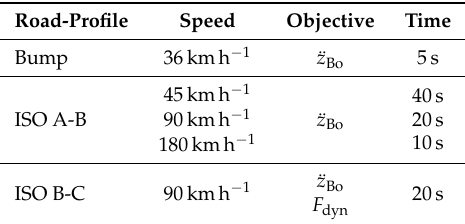
Table 3. Simulation scenarios.